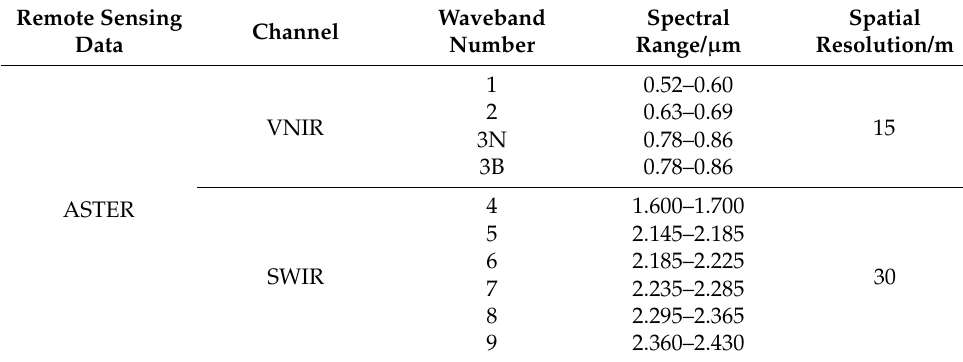
Table 1. ASTER main technical